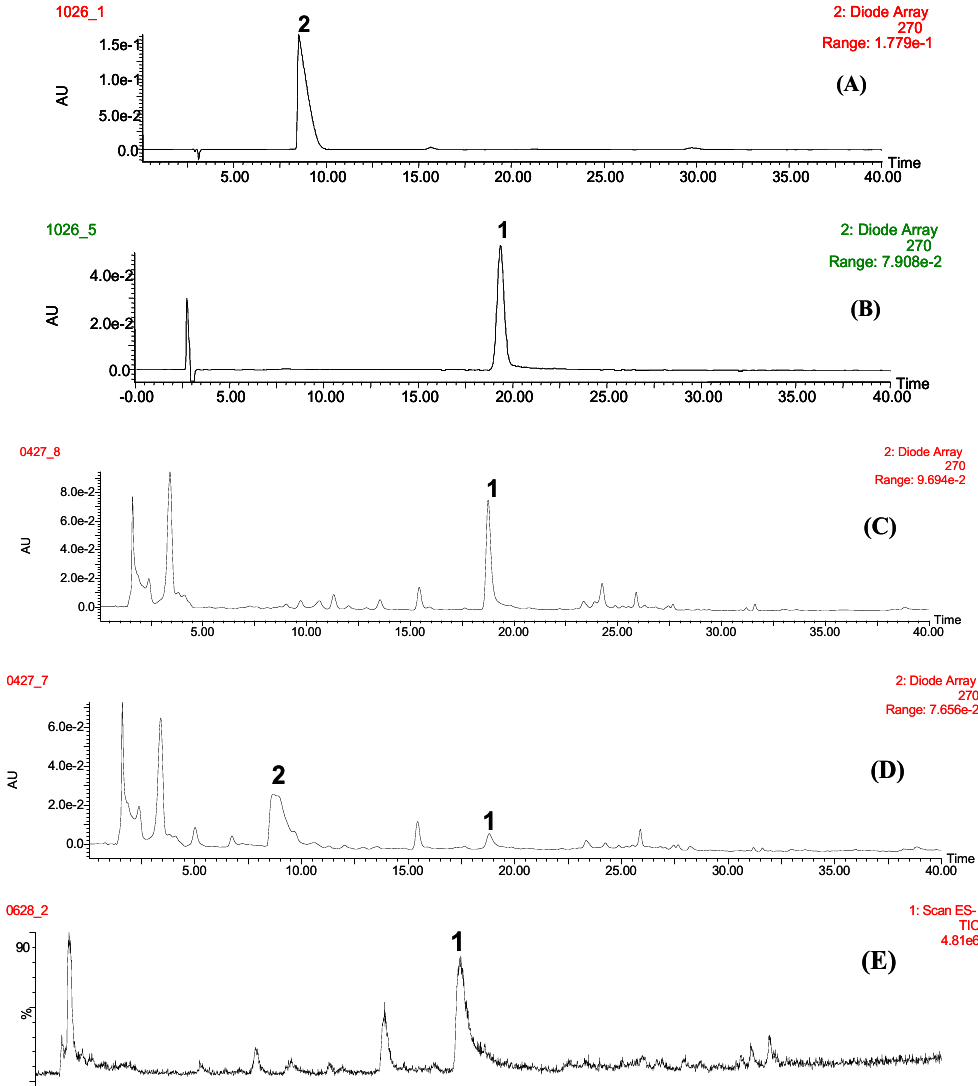
Figure 1. Representative chromatograms of marker compounds and PAR. ( A ) marker compound paeoniflorin sulfonate; ( B ) marker compound paeoniflorin; ( C ) non-fumigated PAR (JPACM-01-01) monitored at UV 270 nm; ( D ) sulfur-fumigated PAR (JPACM-01-02) monitored at UV 270 nm; ( E ) TIC of non-fumigated PAR (JPACM-01-01); ( F ) TIC of sulfur-fumigated PAR (JPACM-01-02); 1 : paeoniflorin; 2 : paeoniflorin